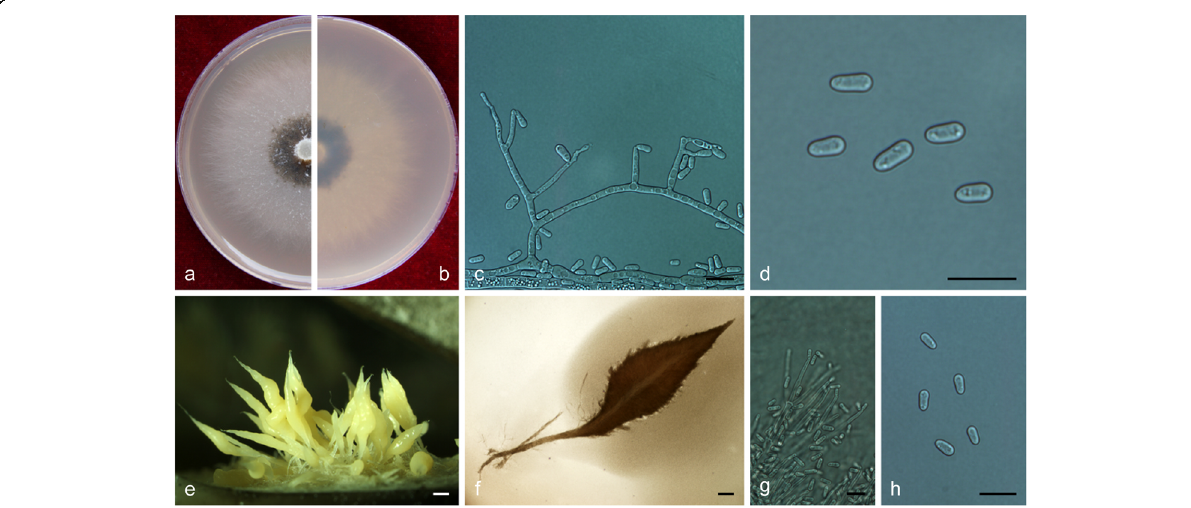
Fig. 16 Morphological characteristics of Ophiostoma peniculi sp. nov. (CFCC 52687, Taxon 7). a – b. Five-day-old cultures on 2% MEA; c – d. Hyalorhinocladiella-like asexual morph: conidiogenous cells and conidia. e. Brush-like conidioma; f. Pesotum-like asexual morph; g – h. Conidiogenous cells of pesotum-like asexual morph and conidia. Scale bars: c – d = 10 μ m; e = 400 μ m; f = 200 μ m; g – h = 10 μ